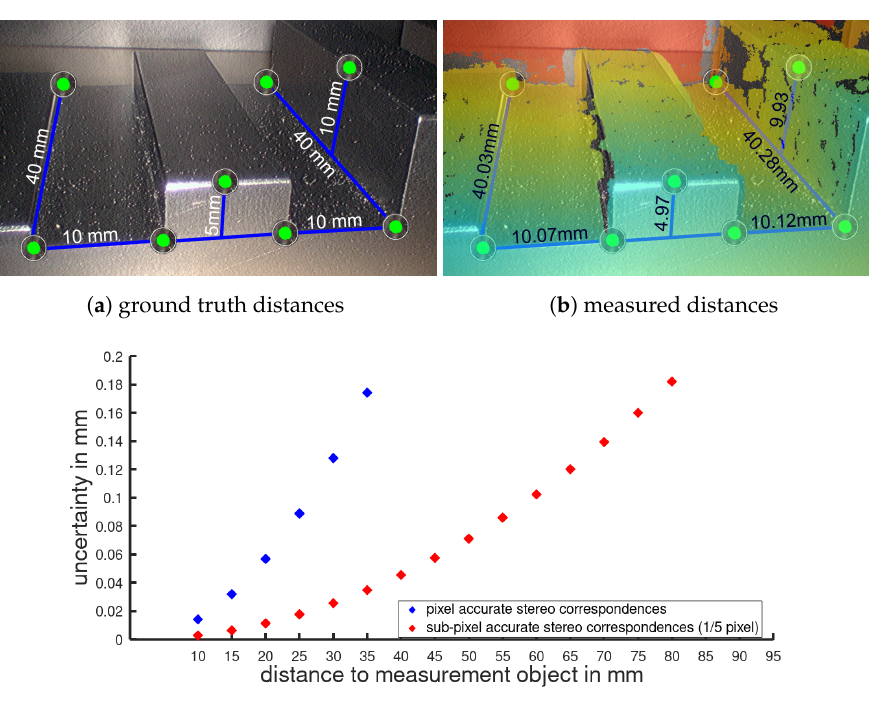
Figure 11. The comparison of the measured distances with ground truth data shows a high measurement accuracy: ( a ) specimen evaluation showing ground truth distances and ( b ) image based measurement results with color encoded depth information (red indicates far range and blue close range). The accuracy consideration in ( c ) shows an increased accuracy for larger working distances through sub-pixel (1/5) accurate stereo correspondences, which is of high importance for surgical intervention as typical working distances are between 20 and 60 mm.